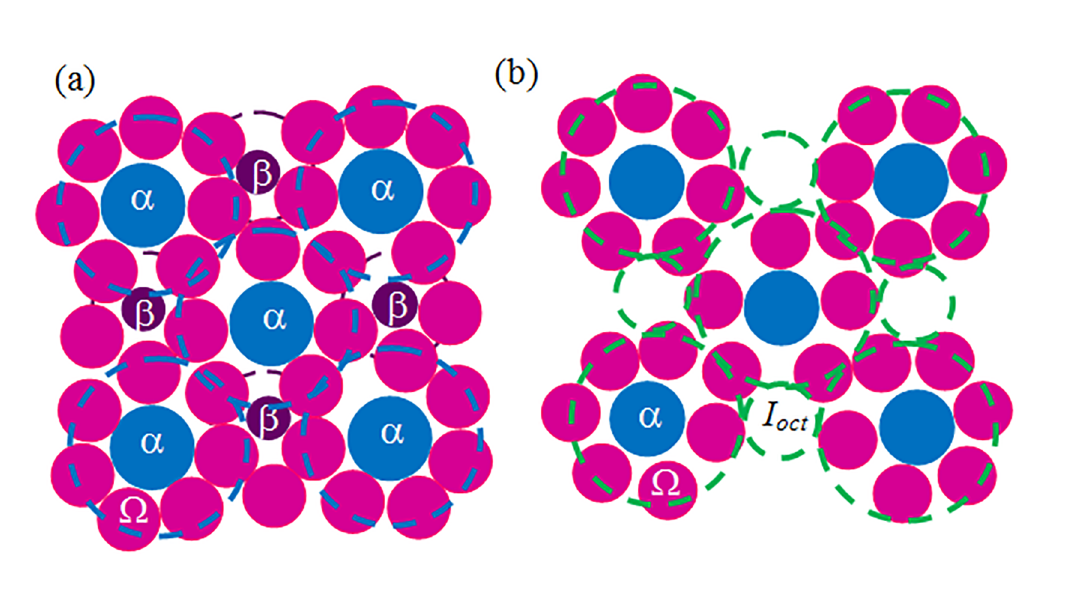
Figure 4. (a) ECP model 129 ; (b) modified ECP model 131 . In the figure, α is the primary cluster-forming solute, β is the secondary solute, Ω is the solvent atom, I is octahedral interstitial oct